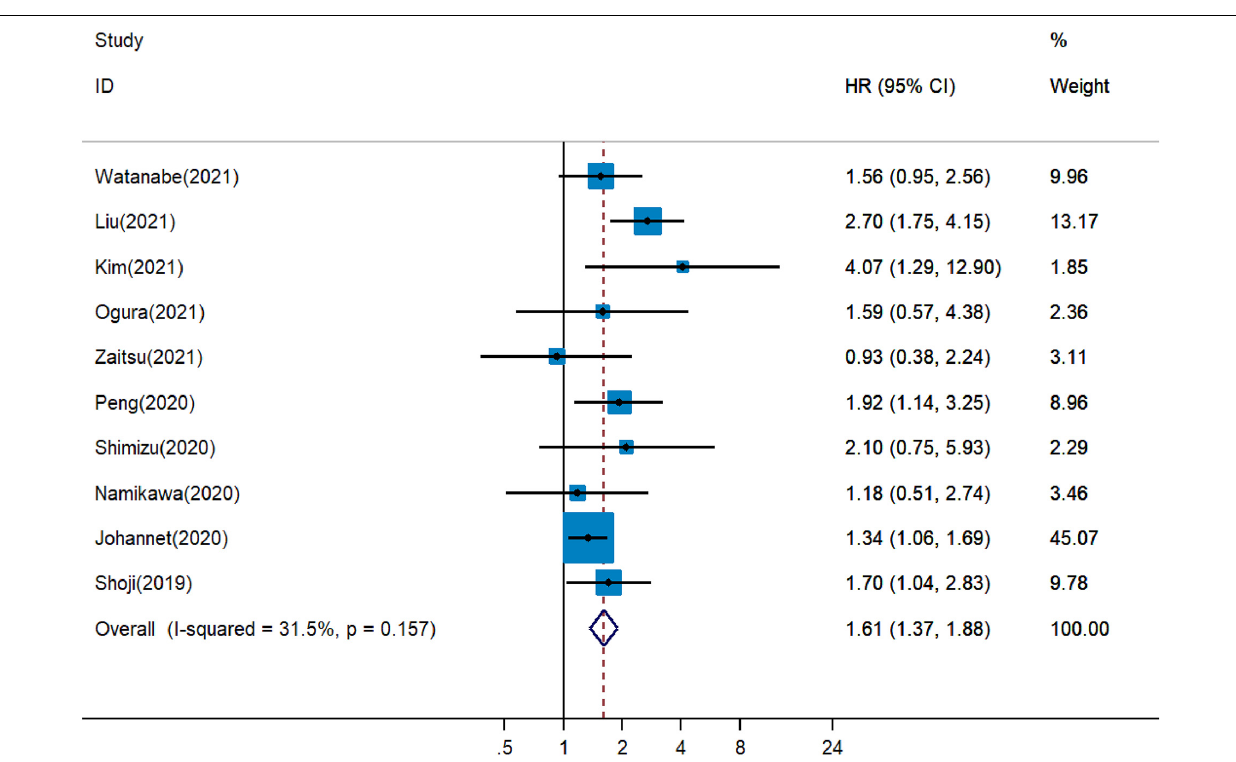
FIGURE 3 | Meta-analysis of impact of PNI on progressive-free survival of patients treated with immune checkpoint inhibitors.